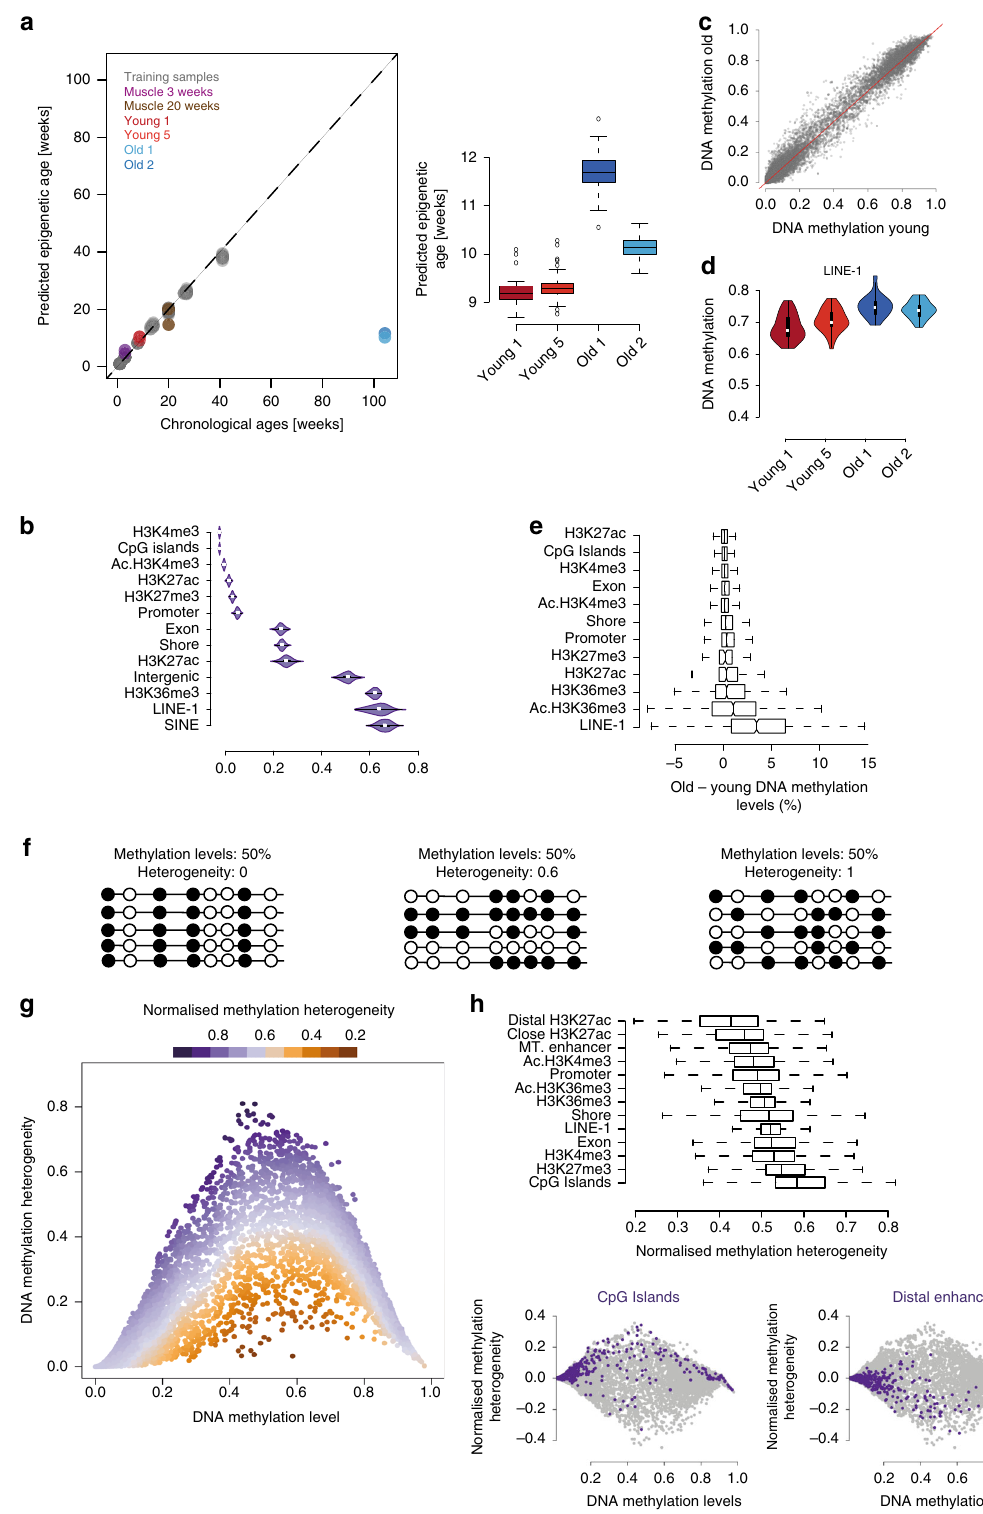
DNA methylation levels